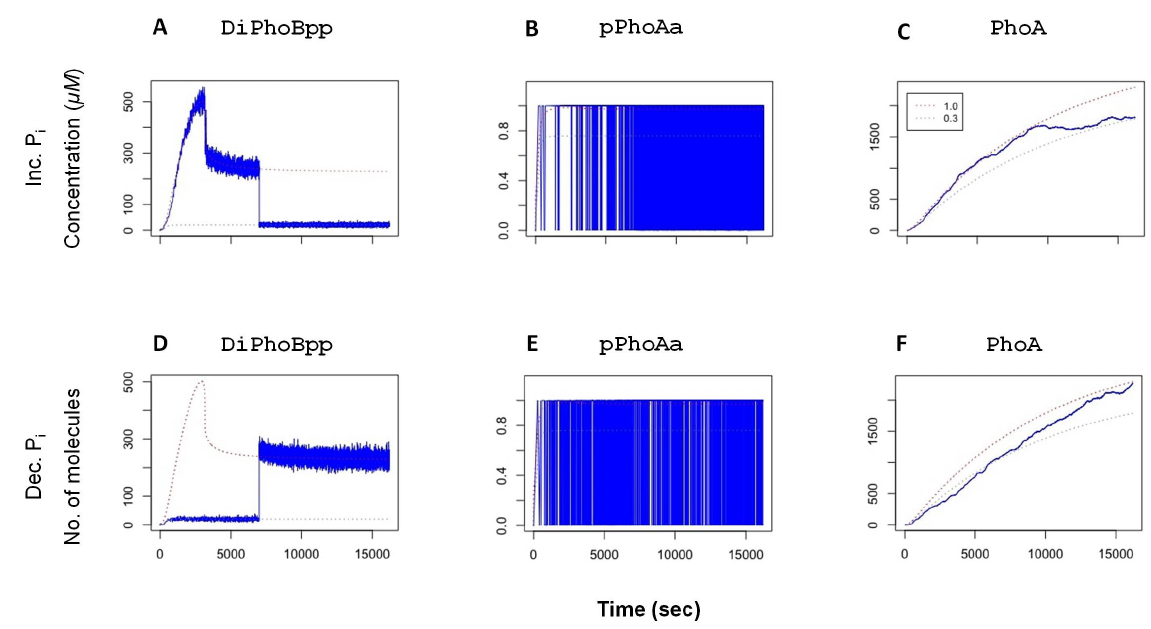
Figure 3. Stochastic time series of simulations. At 7000 simulated seconds, the phosphorylation fold change fc is decreased from 1.0 to 0.3 (top row) for ( A ) DiPhoBpp , ( B ) pPhoAa and ( C ) PhoA . or increased from 0.3 to 1.0 (bottom row) in relation to a change in P i concentration for ( D ) DiPhoBpp , ( E ) pPhoAa and ( F ) PhoA . For comparison, the deterministic trajectories are plotted with dashed lines. The stochastic simulations are scaled down to one-tenth of the E. coli volume such that there is a single promoter on a plasmid per simulation. The binding and unbinding effects on the promoter become observable in the plots of the active promoter pPhoAa . An increase in the unbinding events results in the fully painted area in the pPhoAa plot. A decrease introduces gaps to the painted area. The right-most column displays the adjustment of the system’s yield, given by PhoA , in response to the change in external P i